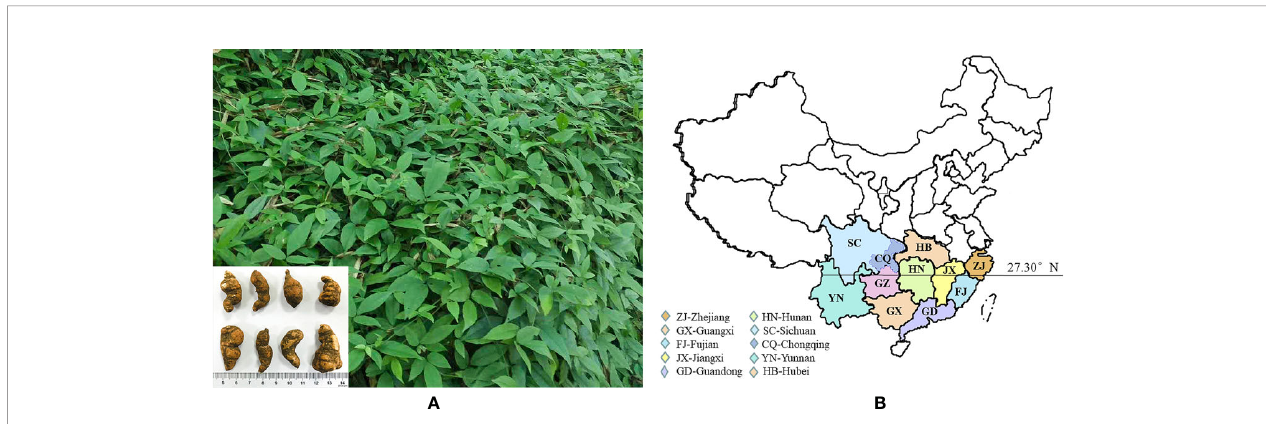
FIGURE 1 | The aerial stem leaf and underground tuber of Tetrastigma hemsleyanum Diels & Gilg in Zhejiang (A) ; Distribution map of wild resources of Tetrastigma hemsleyanum Diels & Gilg (B)